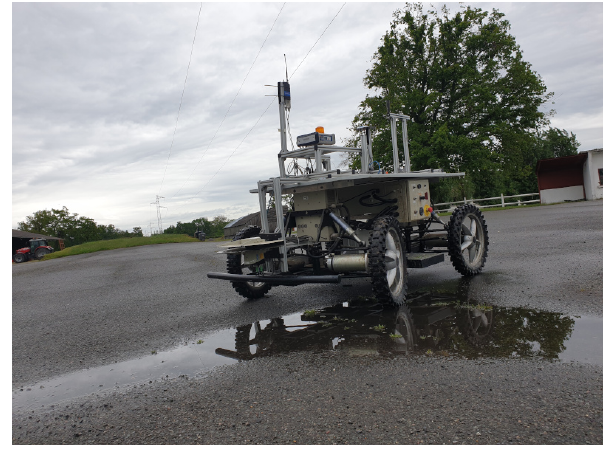
Figure 4. The RobuFAST robotic platform.